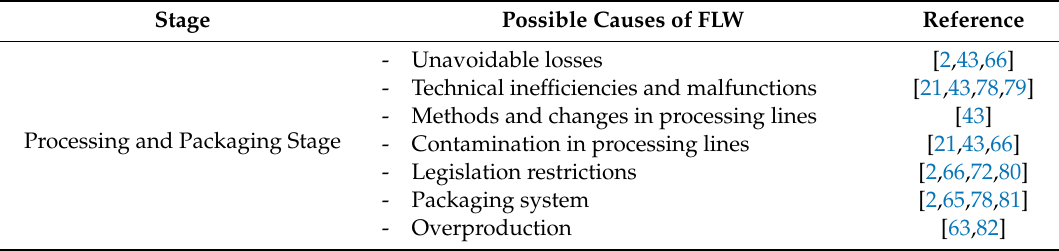
Table 8. Possible causes of FLW at the processing and packaging stage of